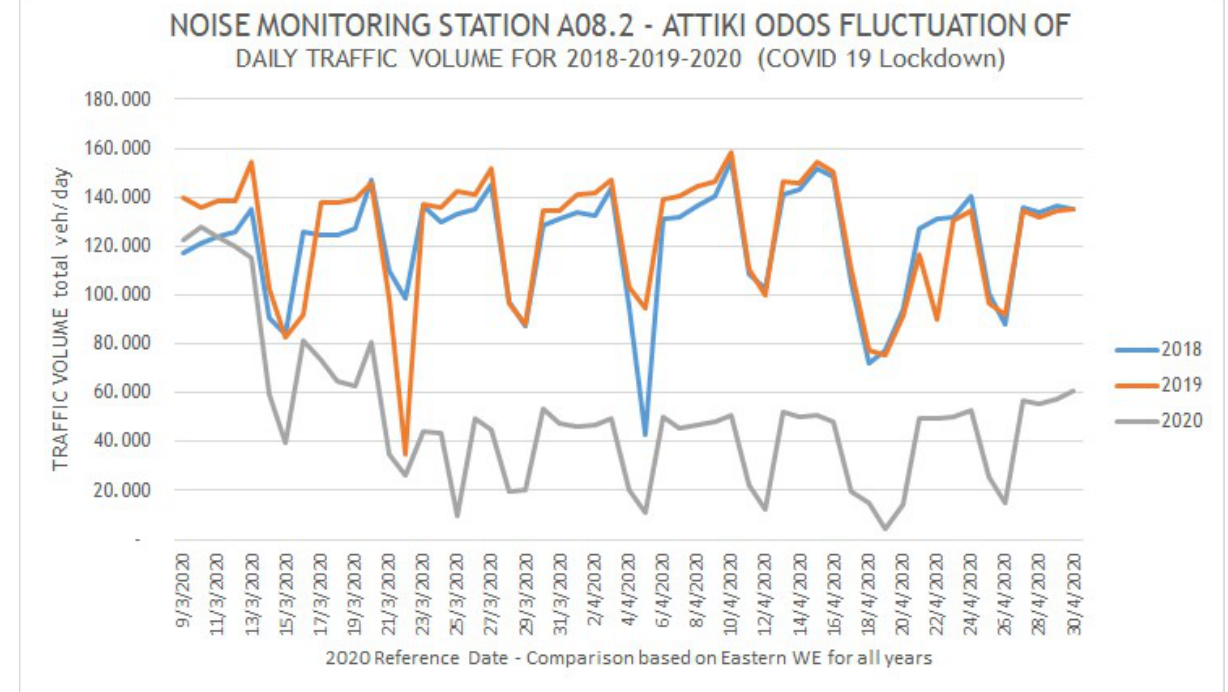
Figure 8c: Daily traflc volume – Noise monitoring station A08.2